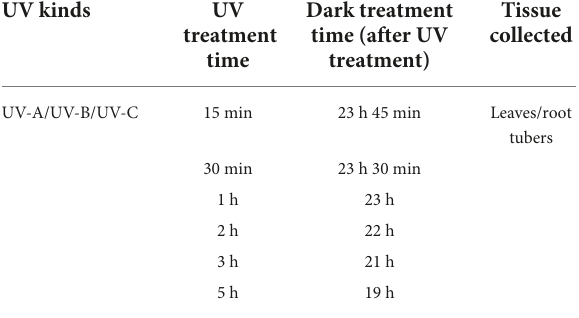
Dark treatment time (after UV treatment)